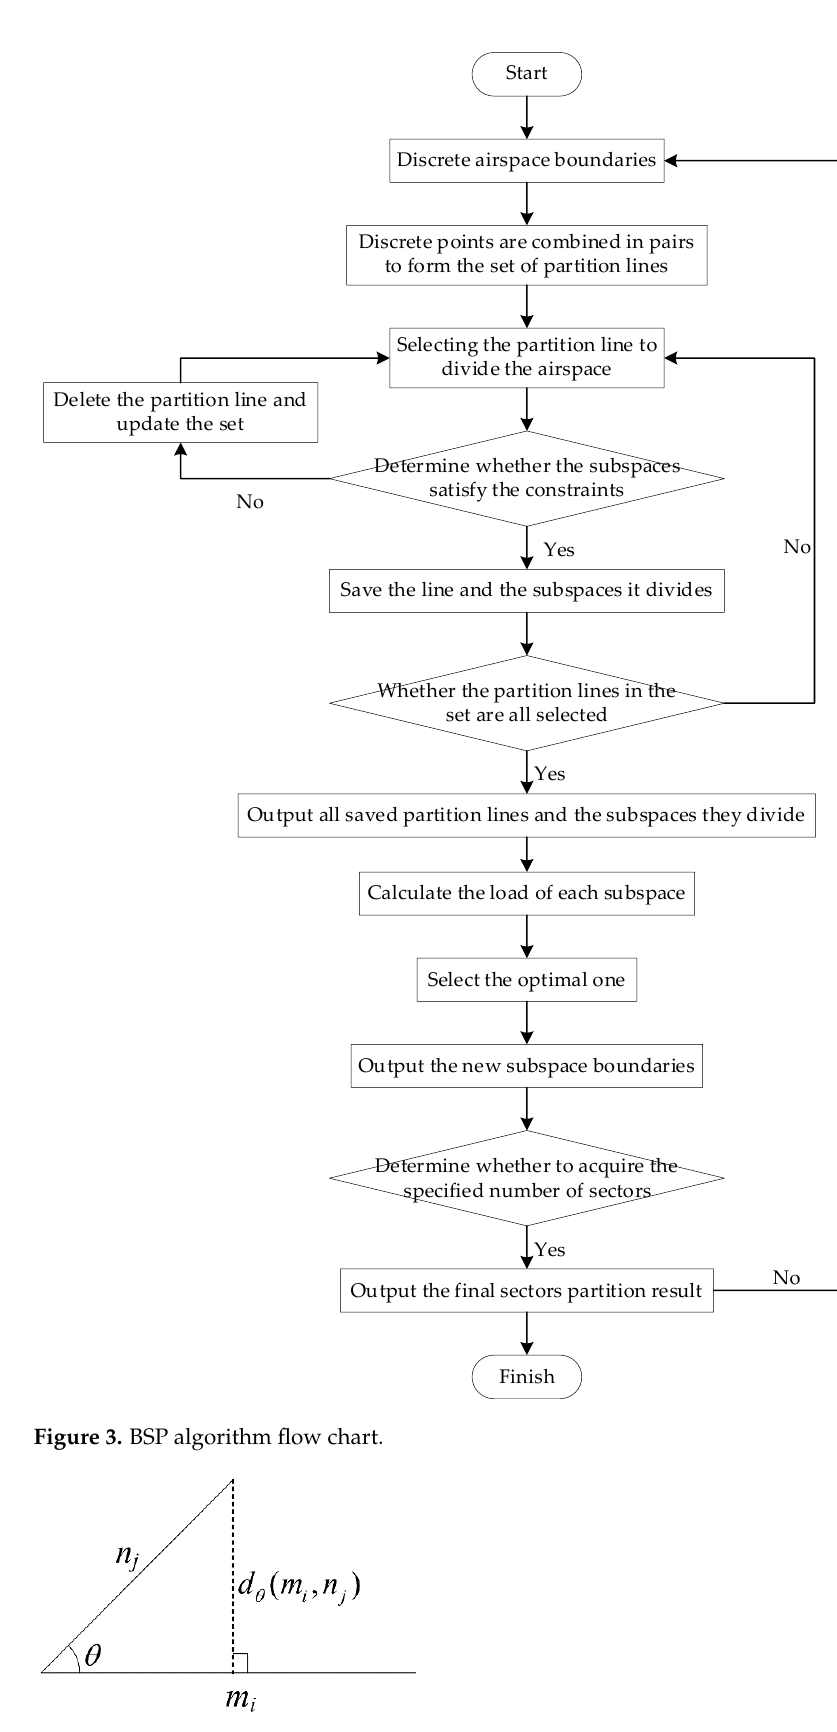
Figure 4. Angle distance illustration.